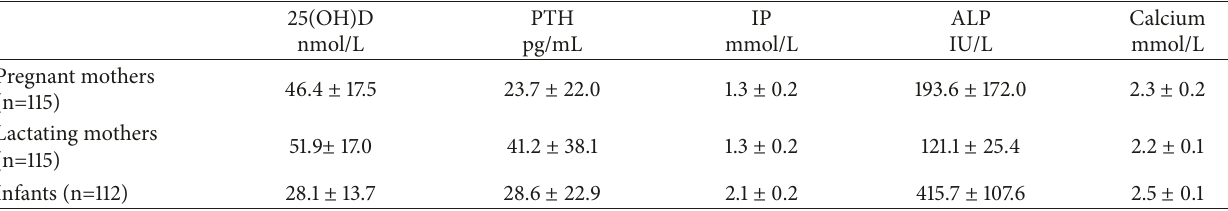
Table 1: Biochemical parameters of the study population.